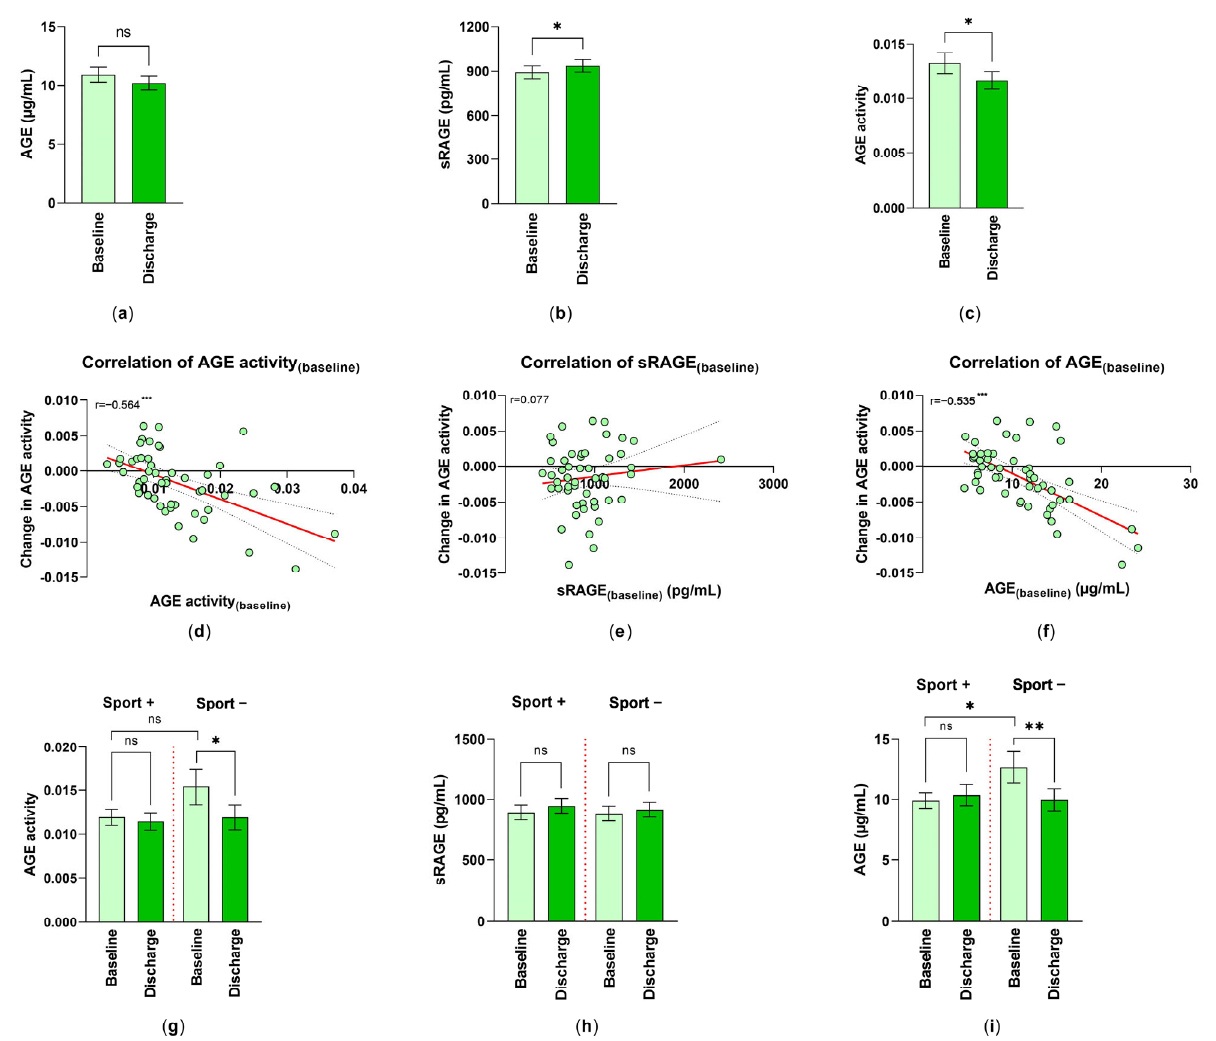
Figure 2. Changes in AGE ligand–receptor system by inpatient rehabilitation: ( a ) AGE levels (n = 51); ( b ) sRAGE (n = 55); and ( c ) AGE activity (AGE/sRAGE-quotient) (n = 51) are shown as mean ± SEM. Statistical differences between baseline (T 0 ) and discharge (T 1 ) were determined via the Wilcoxon matched pairs signed rank; *: p < 0.05. Spearman correlation (r) of AGE activity (changes) (T 1 − T 0 ) with ( d ) AGE activity (baseline) , ( e ) sRAGE (baseline) and ( f ) AGE (baseline) , respectively, were analyzed (n = 51); simple linear regression is given (red line); statistical relevance for ( d ) and ( f ): ***: p < 0.001. The analysis of the effect of physical activity on ( g ) the changes of AGE activity (n Sport+ = 32, n Sport − = 19); ( h ) the changes in the serum levels of sRAGE (pg/mL) (n Sport+ = 35, n Sport − = 20); and ( i ) the serum levels of AGE (n Sport+ = 32, n Sport − = 19) were performed. Differences between the patient groups with/without daily exercises were measured and the values were expressed as mean ± SEM. *: p < 0.05, **: p < 0.01.